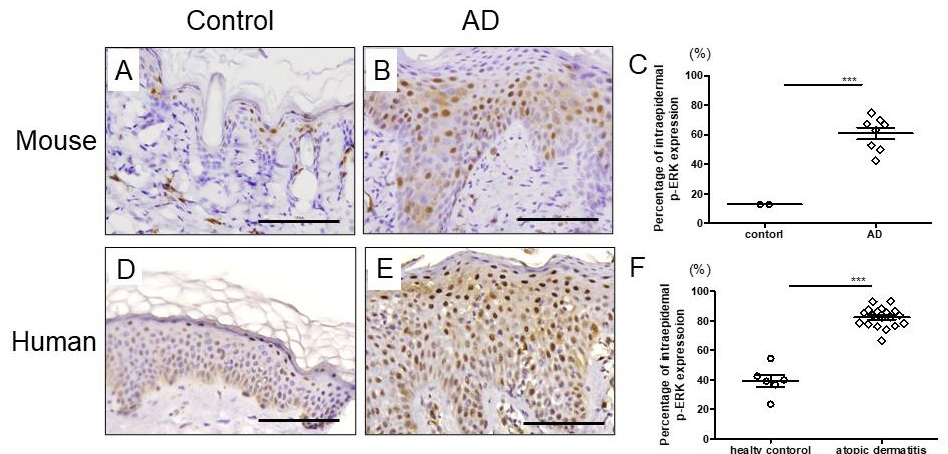
Figure 1. The expression of p-ERK in mouse and human skin. Immunohistochemical staining for p-ERK in normal ( A , D ) and AD ( B , E ) skin. Scale bar: 100 μm ( C ) Percentage of intraepidermal p-ERK expression of control (n = 2) and AD (n = 8) in mice. ( F ) Percentage of intraepidermal p-ERK expression of control (n = 6) and AD (n = 17) in human. All data are presented as mean ± standard error of the mean (S.E.M.). *** p < 0.001 Student’s unpaired two-tailed t